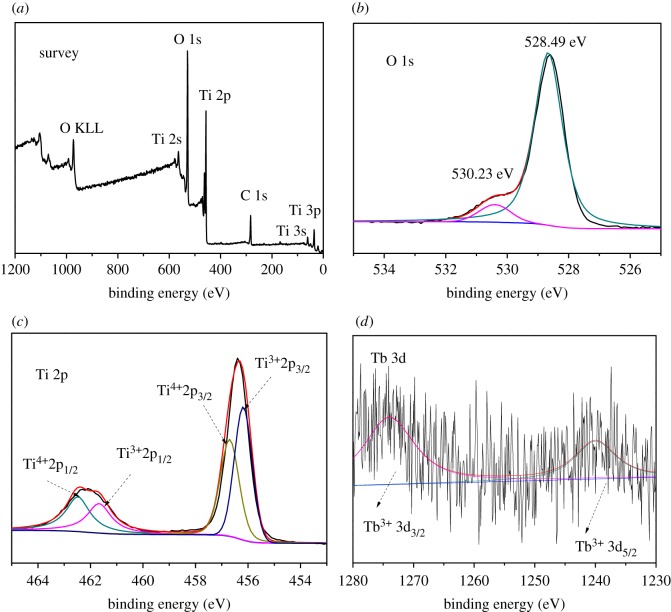
XPS patterns of 1.0%Tb–TiO2 calcined at 500°C for 4 h. (a) Survey spectra; (b) O 1s region; (c) Ti 2p region; (d) Tb 3d region.